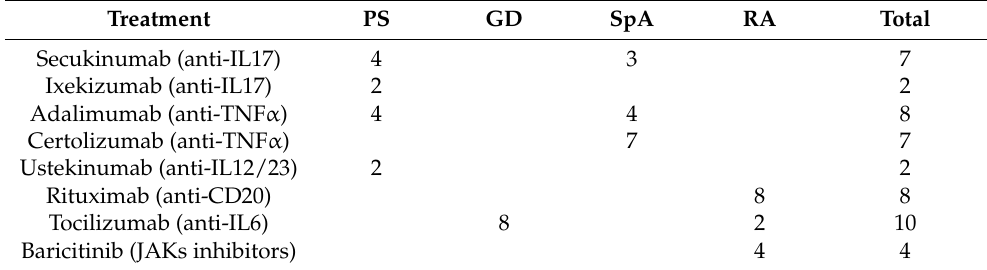
Table 2. Treatment received by patients with immune-mediated inflammatory disorders (IMID).